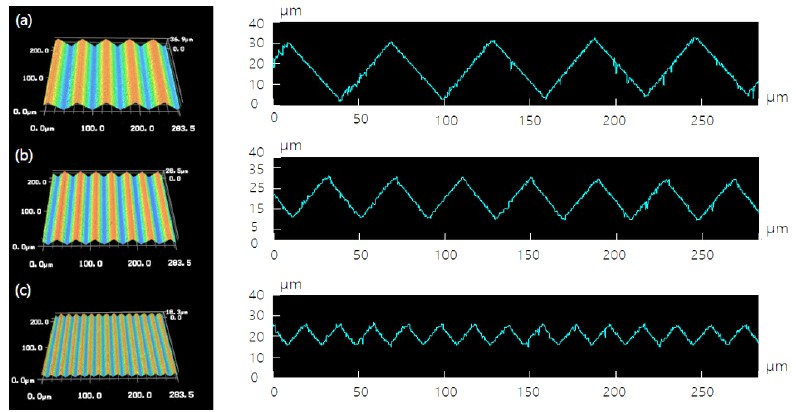
Figure 4. Confocal microscopy images of the replicated pattern on the polymer substrate with ( a ) 10 µ m, ( b ) 20 µ m, and ( c ) 30 µ m depths.